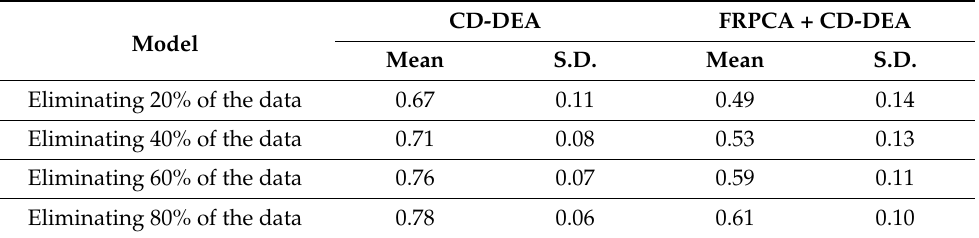
Table 4. The comparison outcomes of two models in different